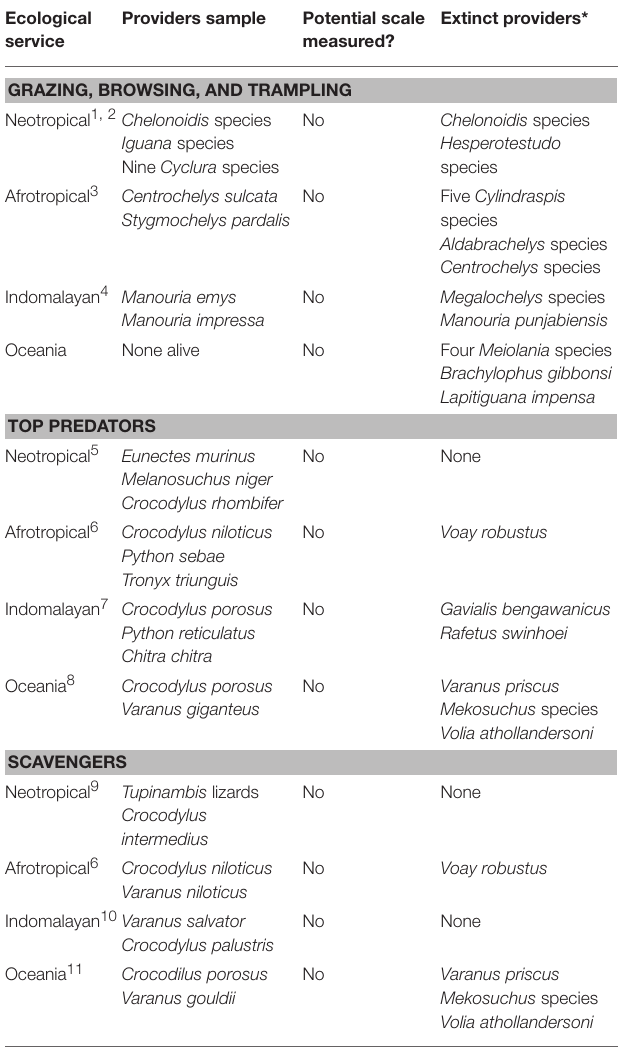
TABLE 3 | Examples of reptiles as trophic agents. Ecological